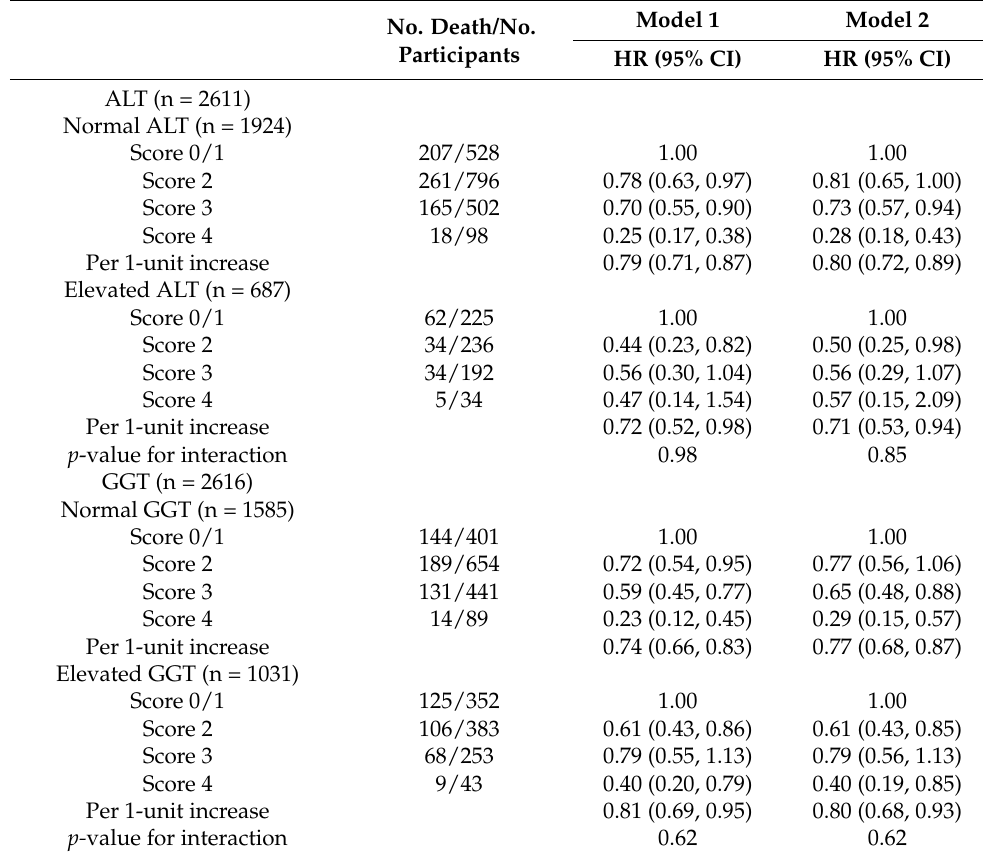
Table 4. Associations between healthy lifestyle and all-cause mortality in MAFLD participants with and without elevated liver